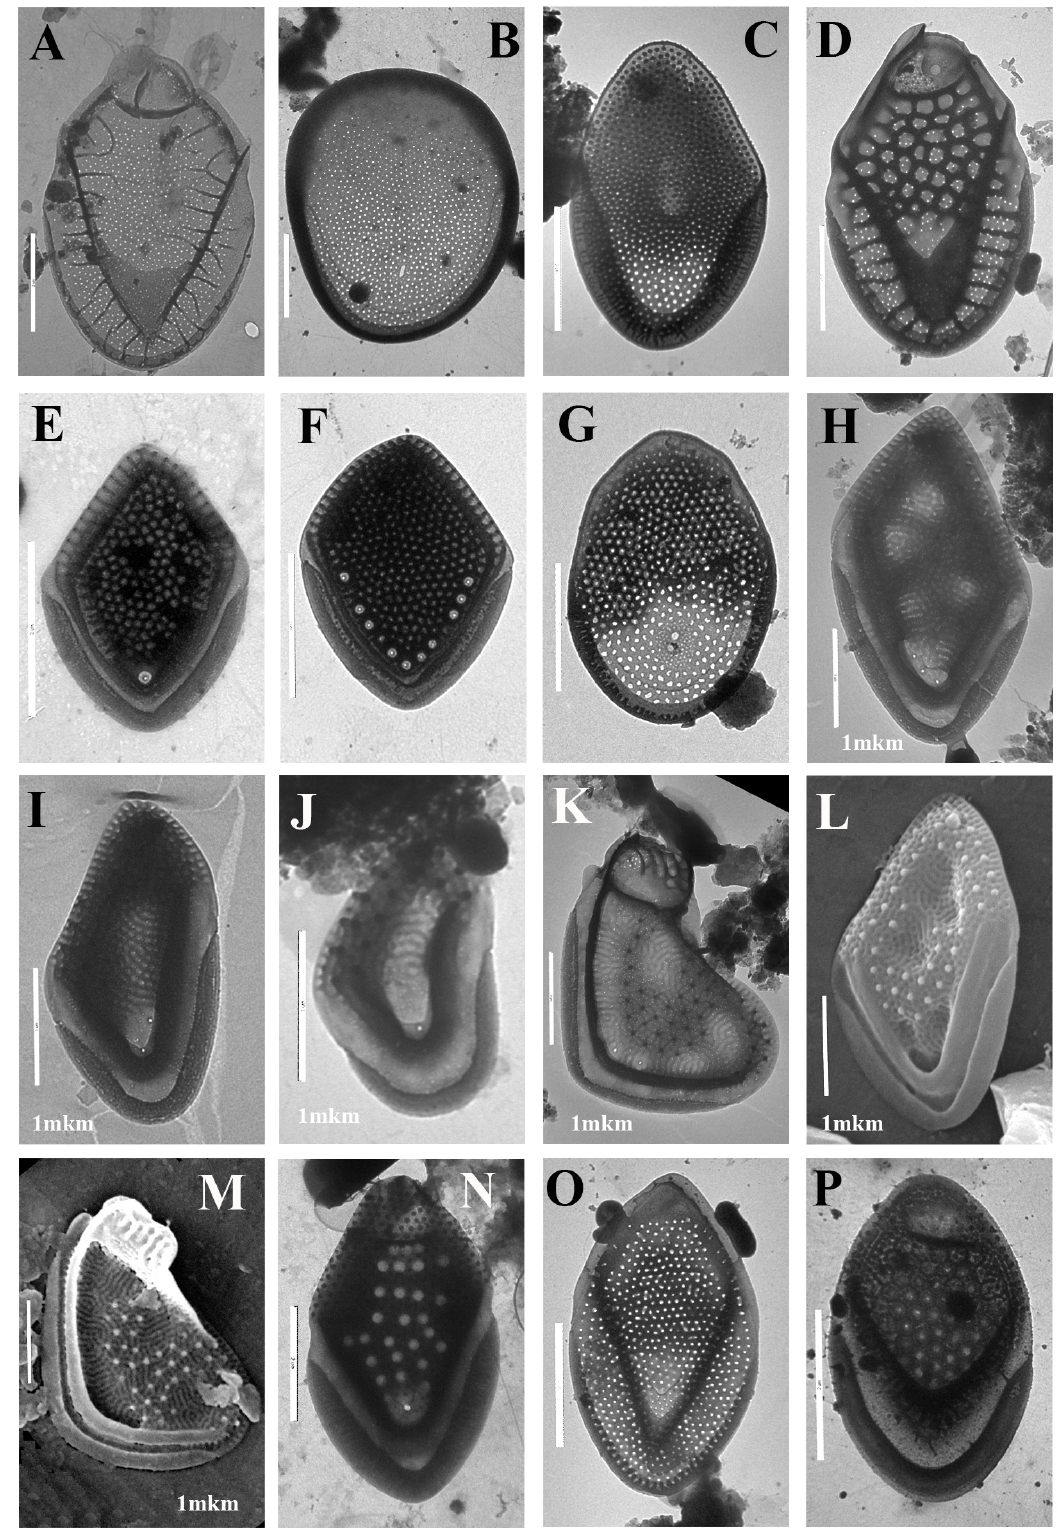
Figure 2. Mallomonas . ( A ). M. acaroides . ( B ). M. caudata . ( C ). M. ceylanica . ( D ). M. crassisquama . ( E ). M. favosa f. favosa . ( F ). M. favosa f. gemina . ( G ). M. hexareticulata . ( H – M ). M. grata . ( N ). M. guttata . ( O ). M. kenyana . ( P ). M. korshikovii . Scale bars: ( A – G , N – P ): 2 μ m; ( H – M ): 1 μ m. TEM: ( A – K , N – P ); SEM: ( L – M ).